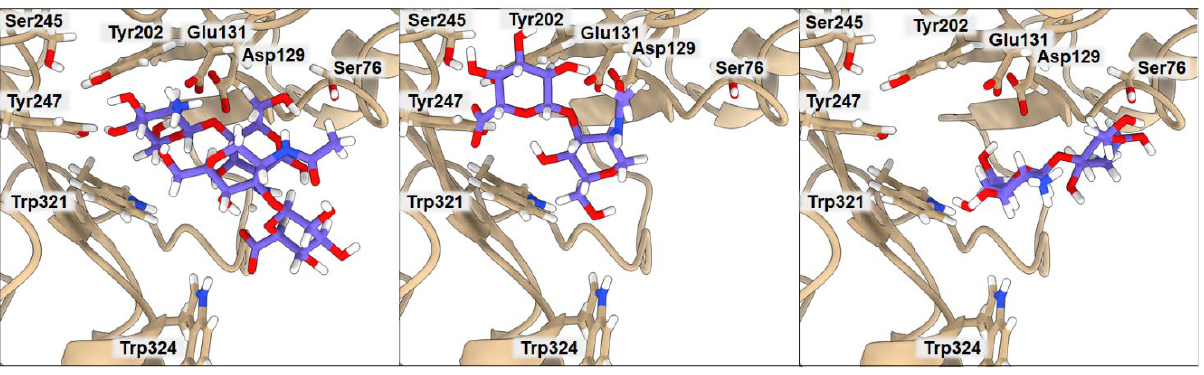
Figure 3. Ribbon representation of the hHyal-1 with docked HA/CHI, HA, and CHI saccharides, from left to right, respectively. Key amino acids that create interactions with ligands are marked in black.